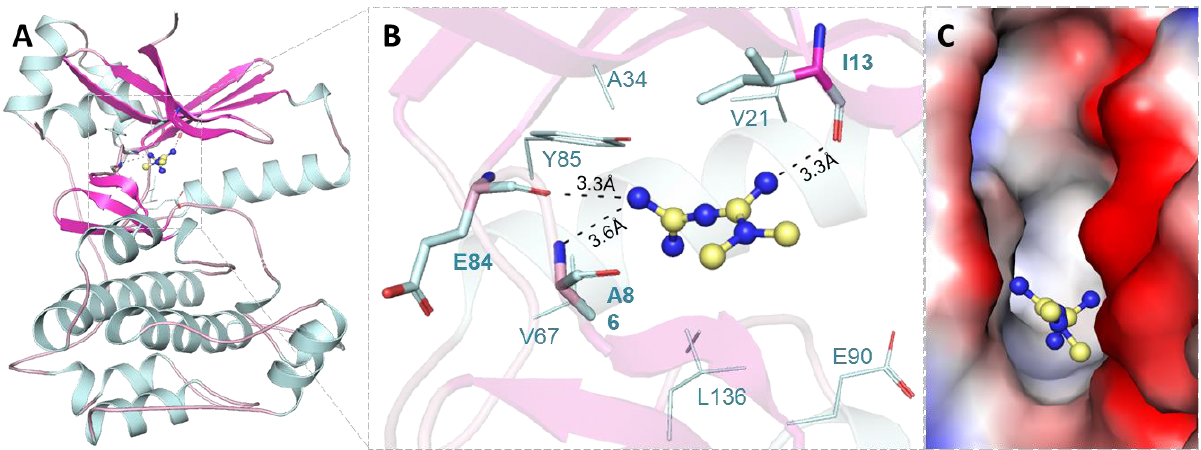
Figure 1. Binding prototype of MARK4 with Mtf. ( A ) Cartoon representation of the protein–ligand complex. ( B ) Magnified view of the Mtf docked pose on MARK4. ( C ) Binding pocket cavity representation of MARK4 occupied with Mtf.